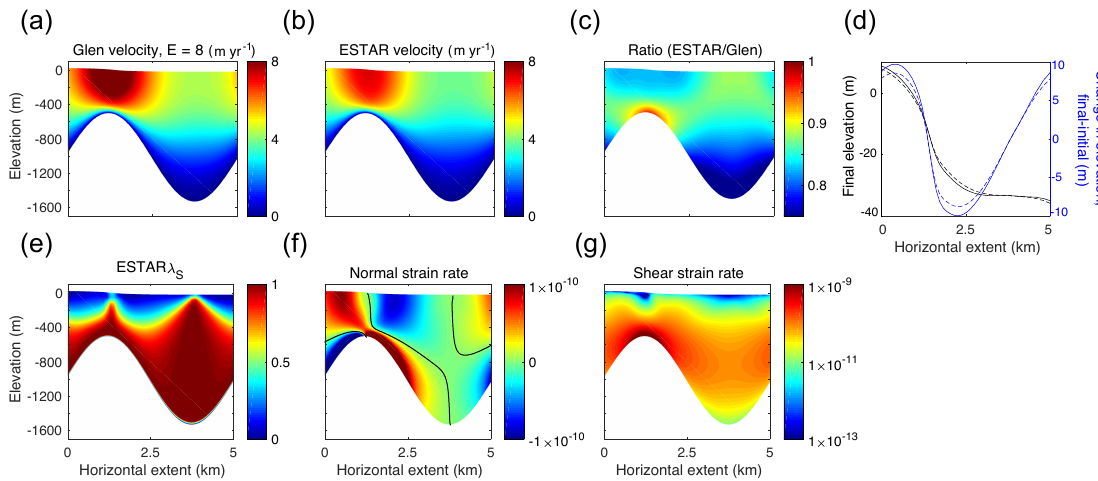
Figure 7. As for Fig. 6, but with L =